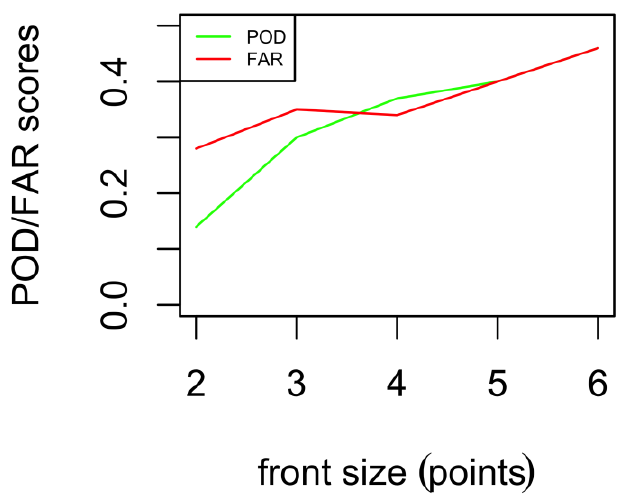
Figure 5. POD and FAR scores as a function of the front